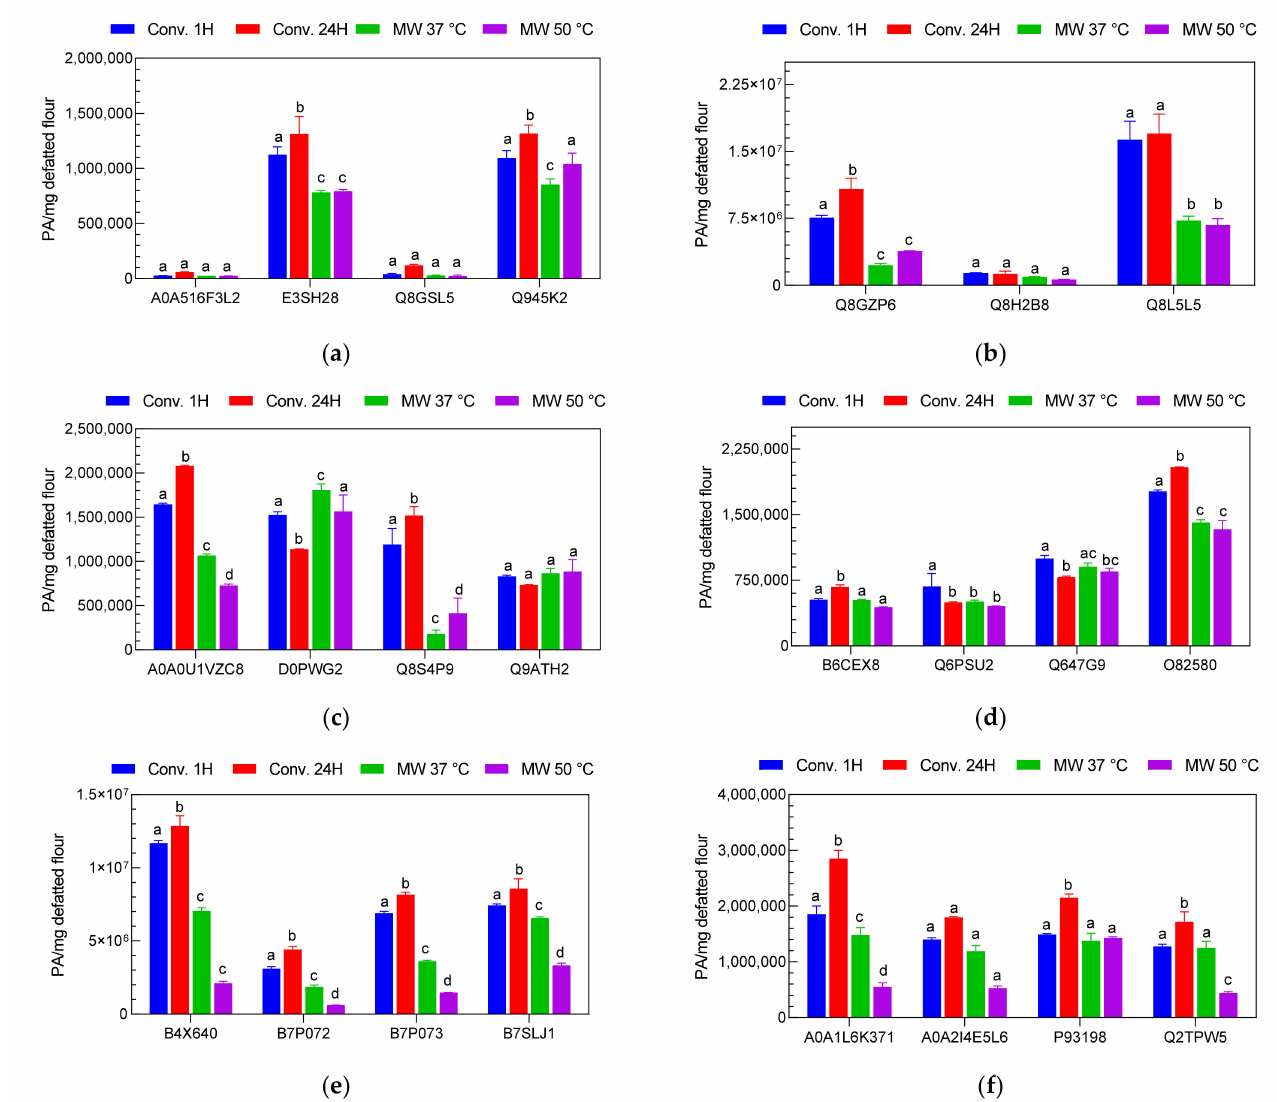
Figure 5. Comparison of the conventional and microwave assisted tryptic digestion on the relative amount of selected allergenic proteins of ( a ) almond, ( b ) cashew, ( c ) hazelnut, ( d ) peanut, ( e ) pistachio and ( f ) walnut expressed as peak area per mg of defatted nut flour. The quantification was performed using the different biomarkers for each protein as determined through method development. Overnight tryptic conventional digestion was performed for all the samples and the experiments were carried out in triplicate ( n = 3). Comparisons were performed per family and different lowercase letters indicate significant differences at p = 0.05 (Tukey